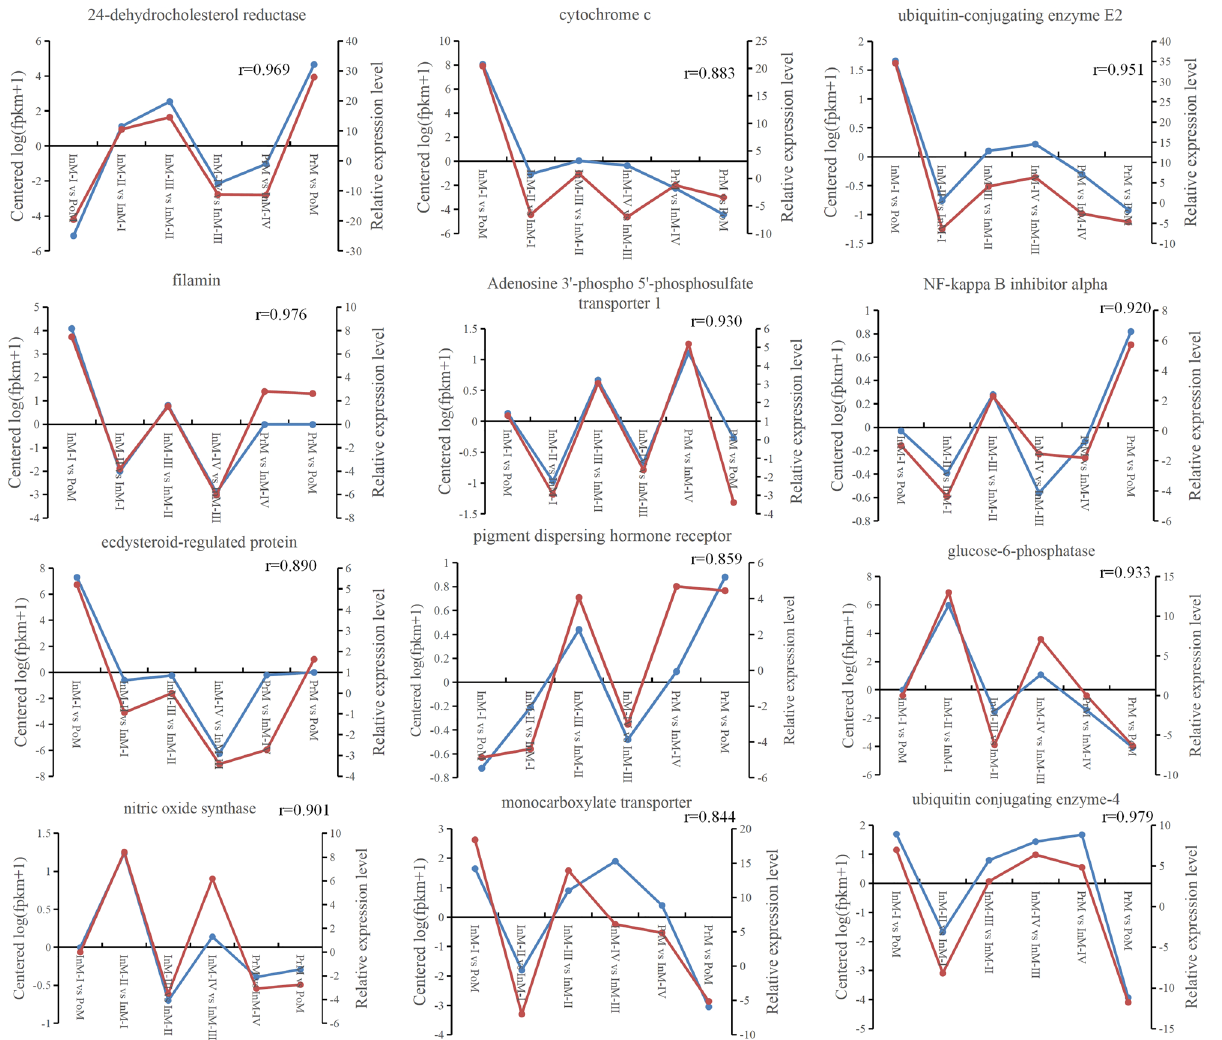
Figure 6. Expression profiles of 12 DEGs from RNA-sequencing (RNA-seq) (blue) and qRT-PCR (red) with alpha-tubulin as a reference gene in different molting